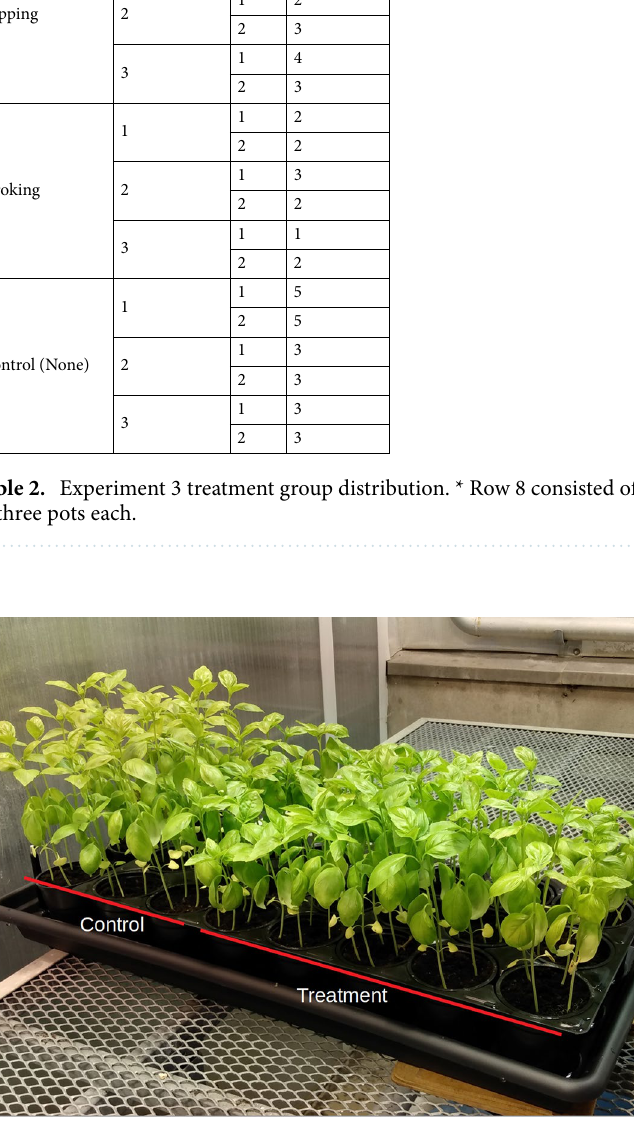
Figure 8. Visual evaluation of Tray1 on the day of measurement, 58 days after sowing, four weeks after the start of